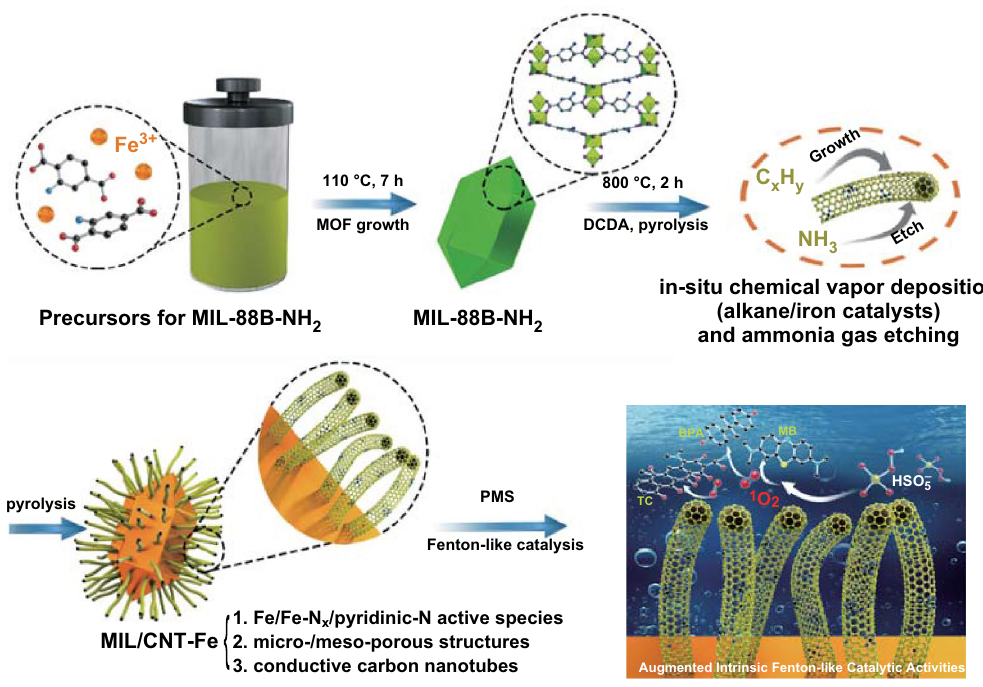
Fig. 1 Illustrated formation procedures for the iron(III)-2-aminoterephthalic frameworks (MIL-88B-NH 2 , MIL = Materials from the Lavoisier Institute) and the resulted CNTs–Fe-decorated carbon hybrids (MIL/CNT–Fe), and the corresponding schematic image of Fenton-like reactions toward the organic